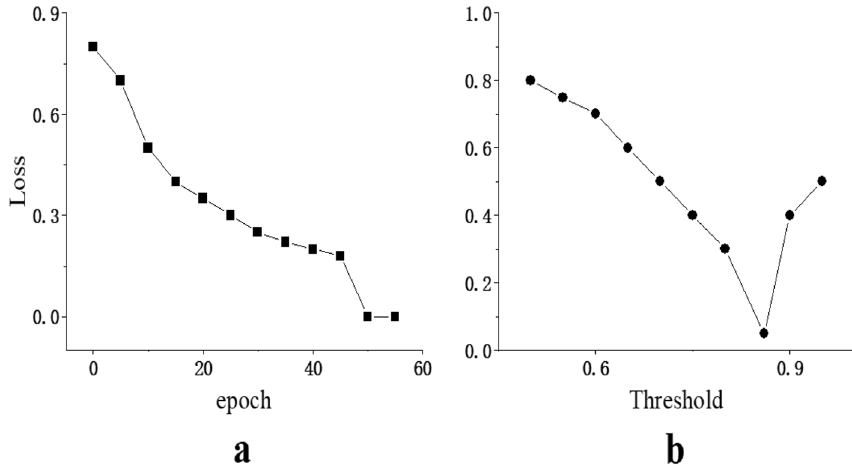
Figure 3. Determination of different parameters.